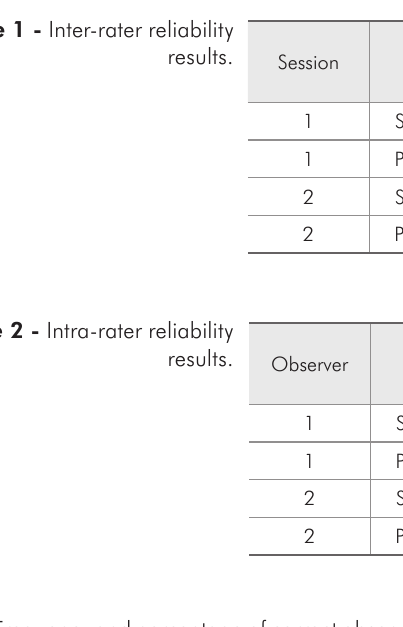
Table 3 - Frequency and percentage of correct observations in determining the defects in the images, and chi-square test for equality of proportions.